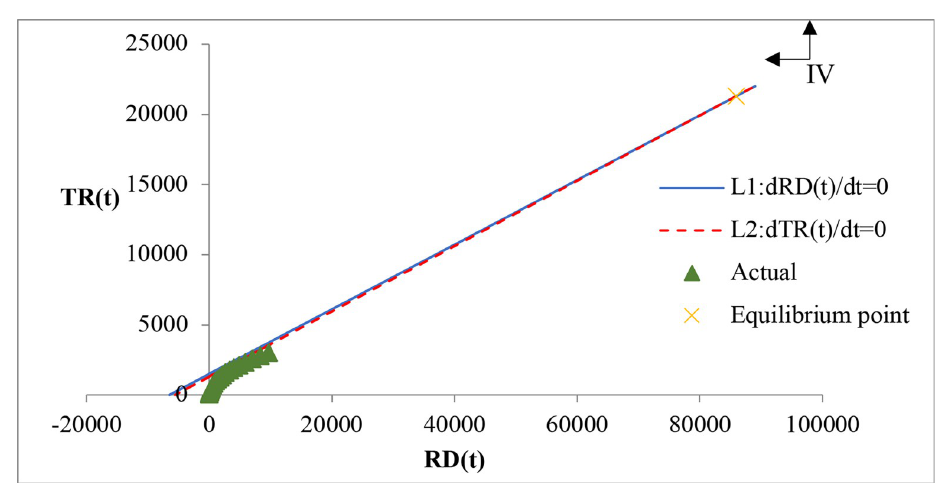
Fig 4. Overall view of the evolutionary trend of RD and